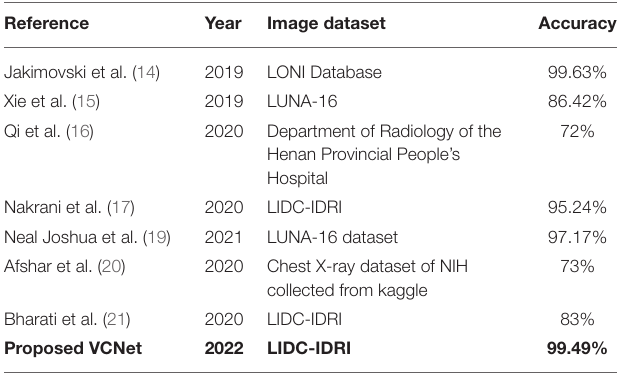
TABLE 3 | Comparative analyses in terms of accuracy among the proposed VCNET and the State-of-the-Art models. Reference Year Image dataset